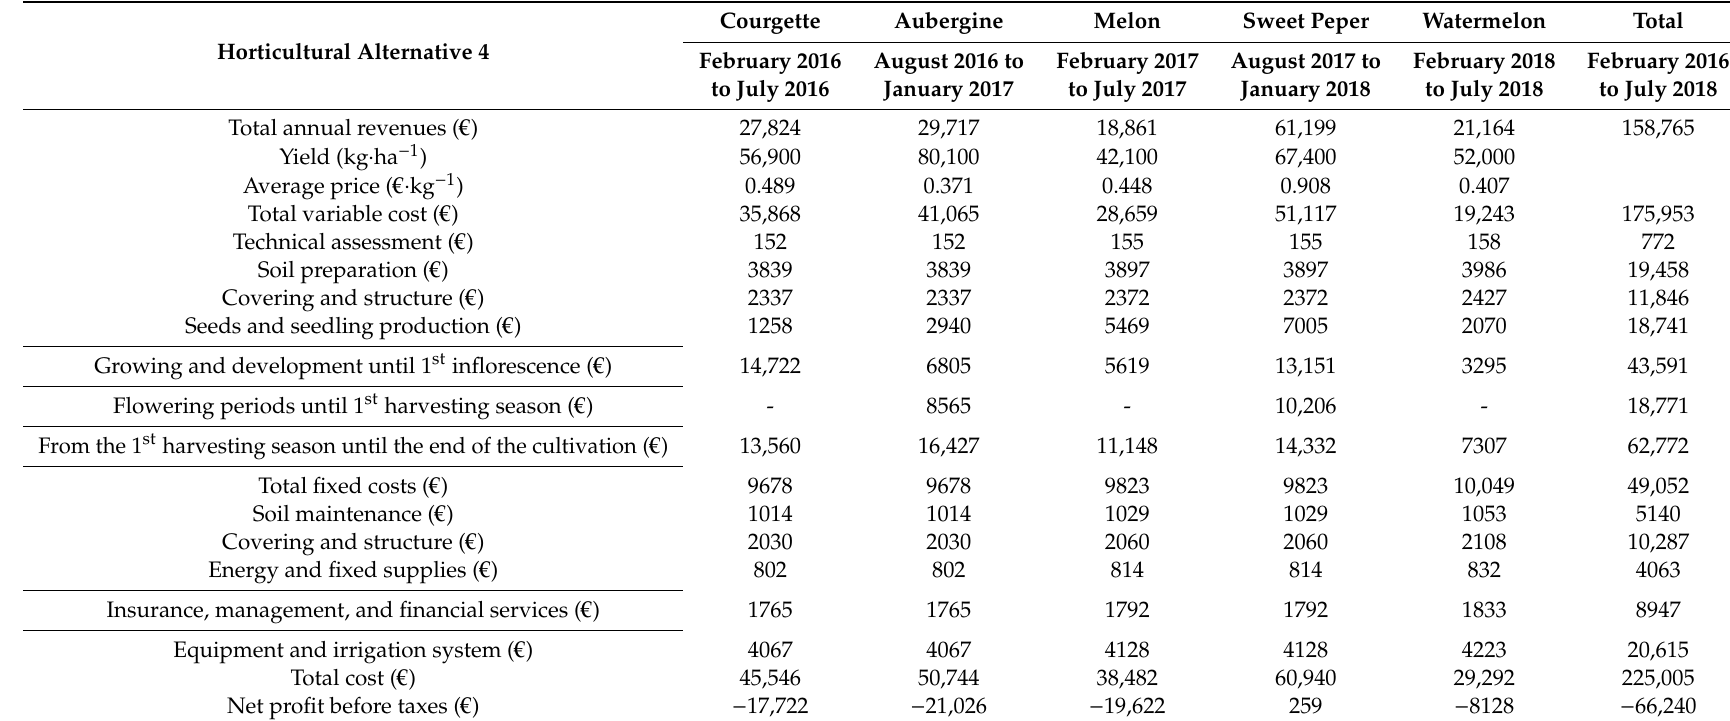
Table A6. Revenues and expenses per hectare imputed to the cultivation of the horticultural alternative 4 in a 30-month cycle